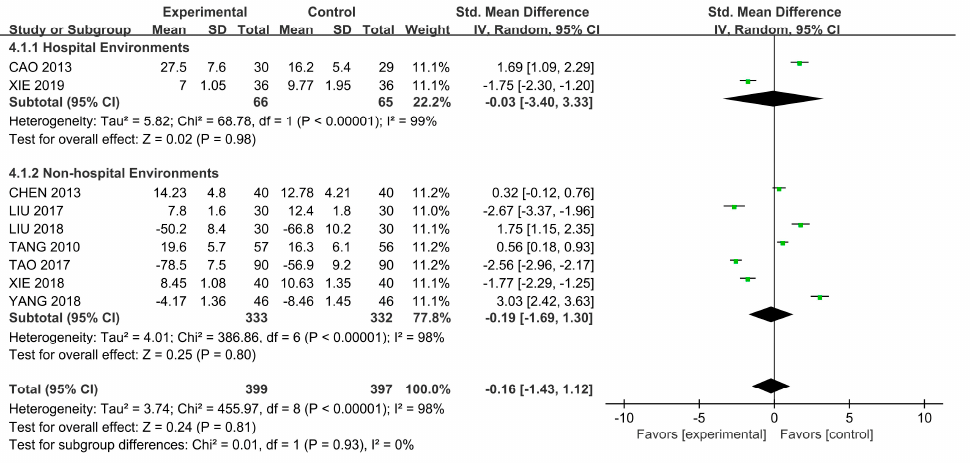
Figure 7. Effects on social functioning.